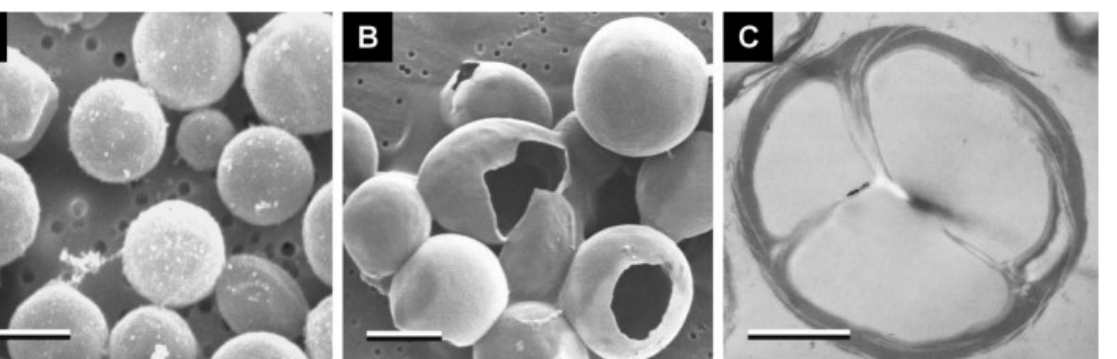
Table 2. Rubber particle size statistics table.